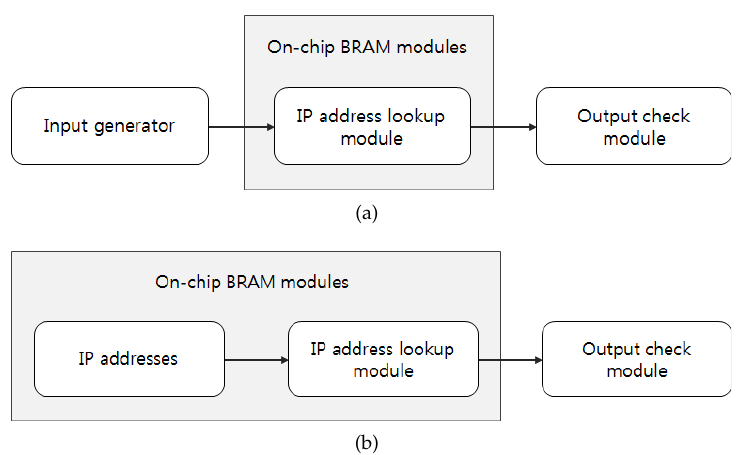
Figure 7. Test flow of field programmable gate array (FPGA)-based IP address lookup: ( a ) General case. ( b ) Our